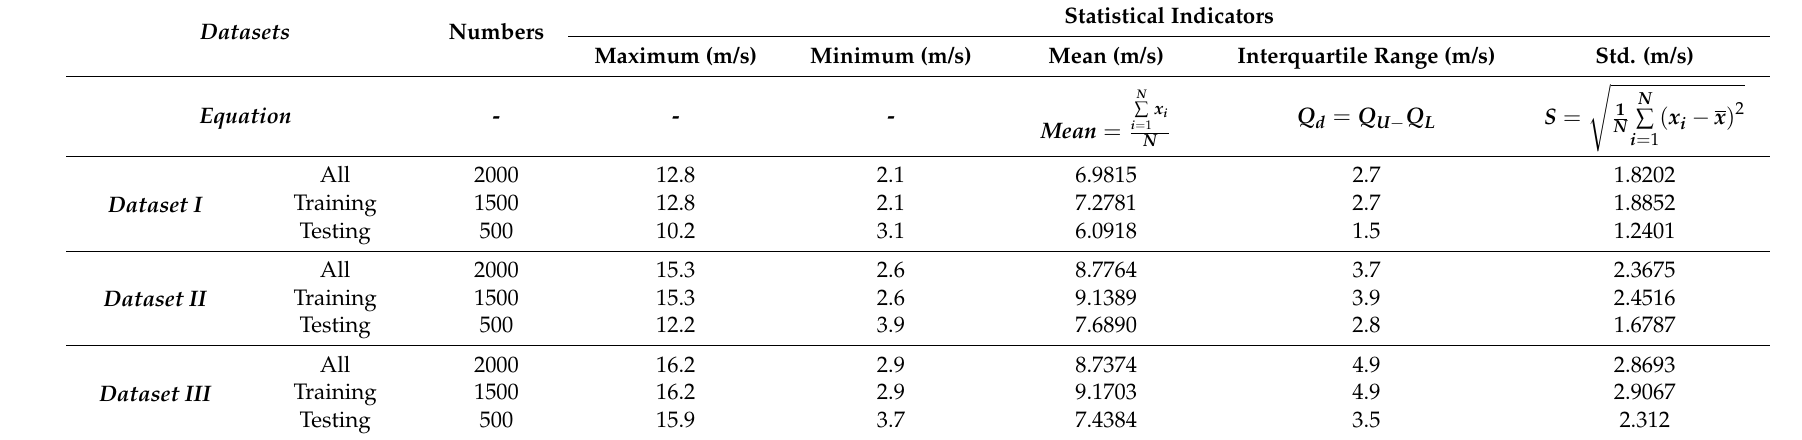
Table 2. Some statistical indicators of the Datasets.